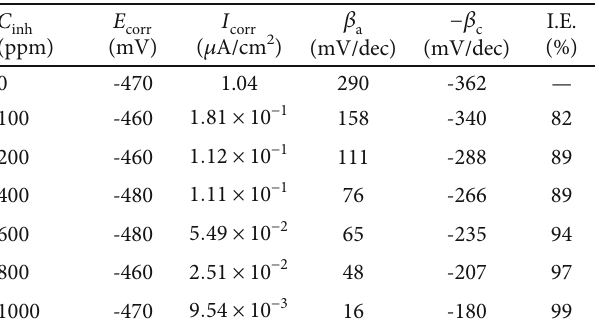
Figure 6: E ff ect of the Sn-metallic complex concentration on the polarization curves for 1018 carbon steel immersed in 0.5M H Table 3: Electrochemical parameters obtained from polarization curves for carbon steel immersed in 0.5M H concentrations of Sn-metallic